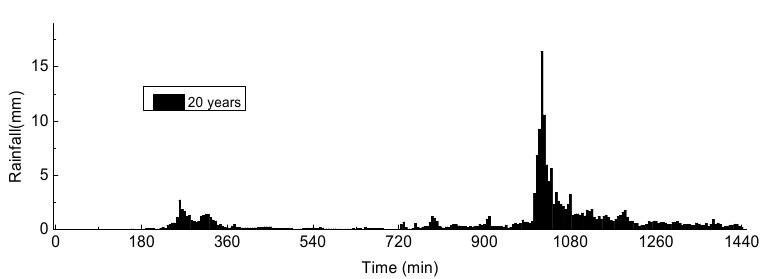
Figure 4. Design rainfall pattern for the twenty-year recurrence period.